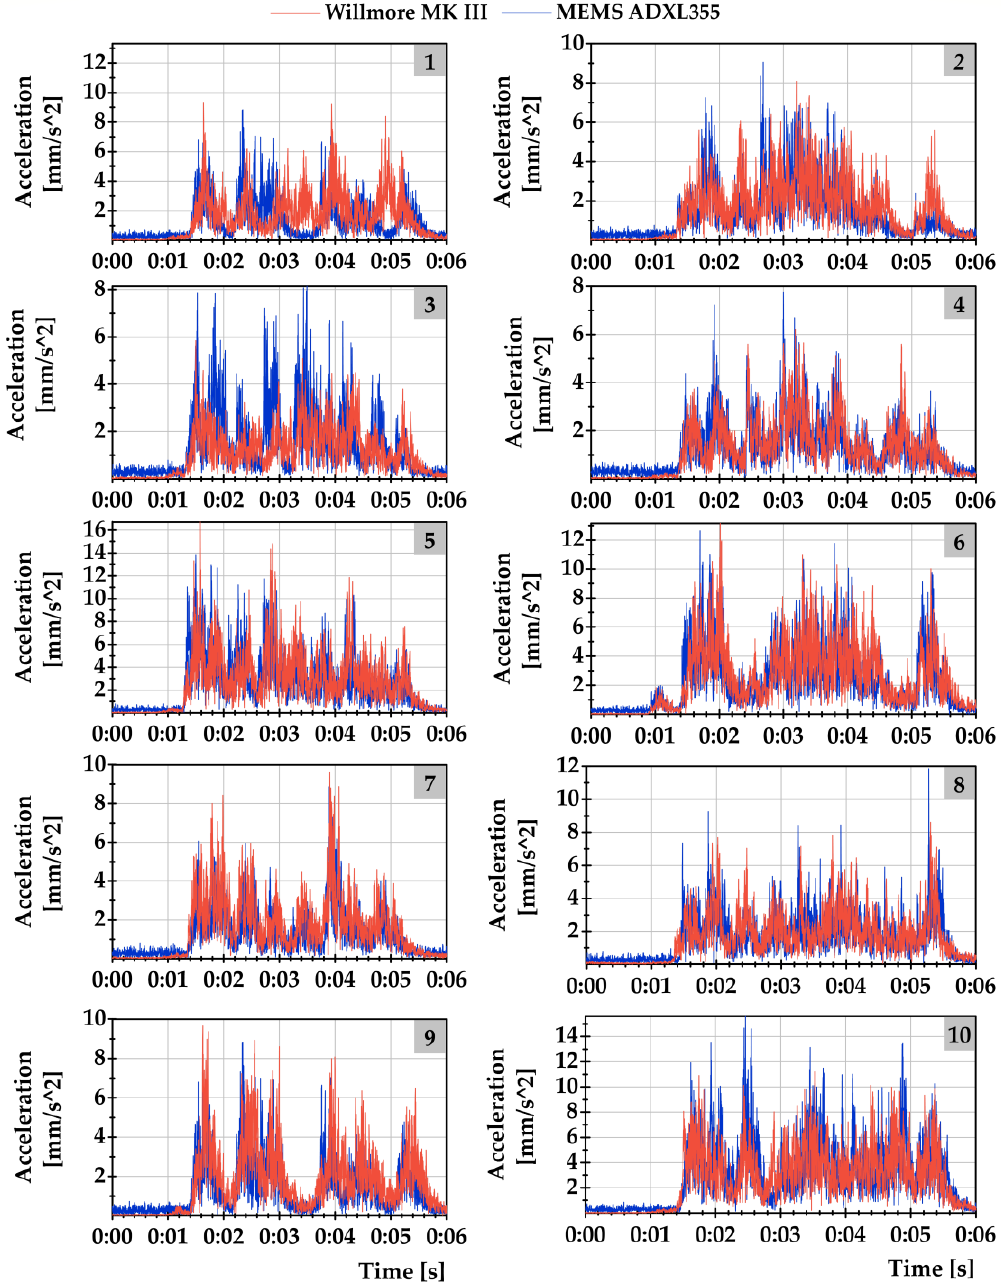
Figure 7. Superimposition of 3D peak ground motion plots determined for each recorded blasting.